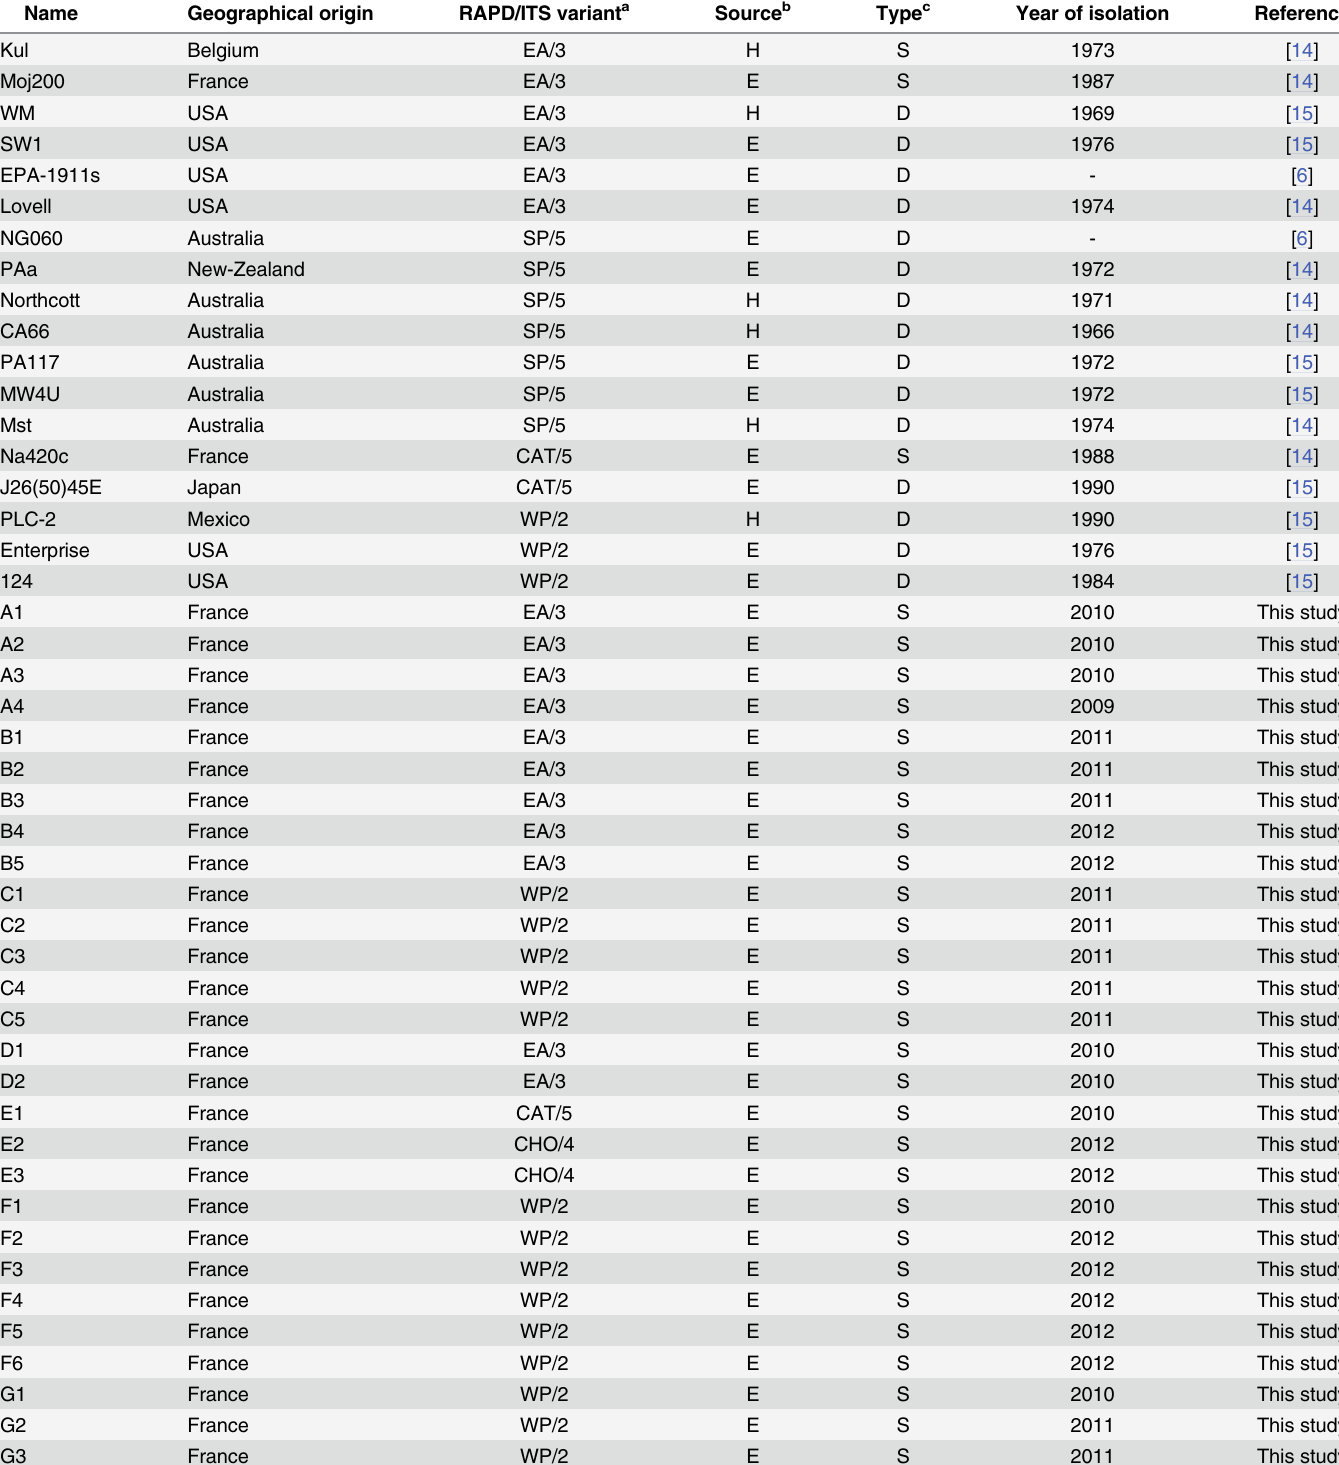
Table 1. DNA and strains used with geographical